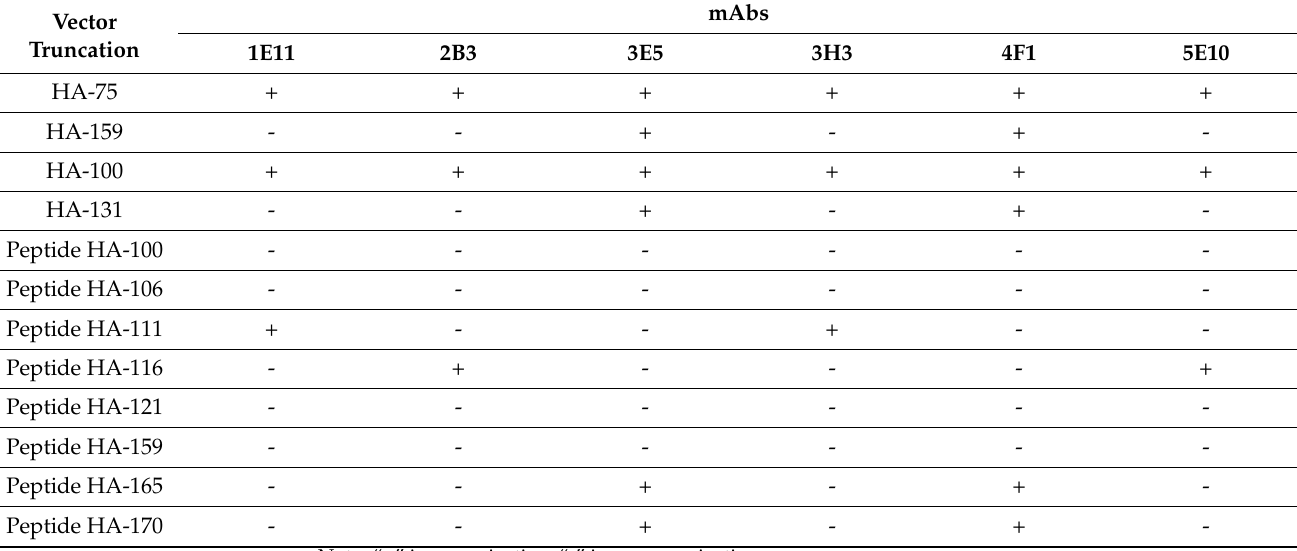
Table 4. The reactivities of six monoclonal antibodies with the turncated HA protein and the epitope in HA